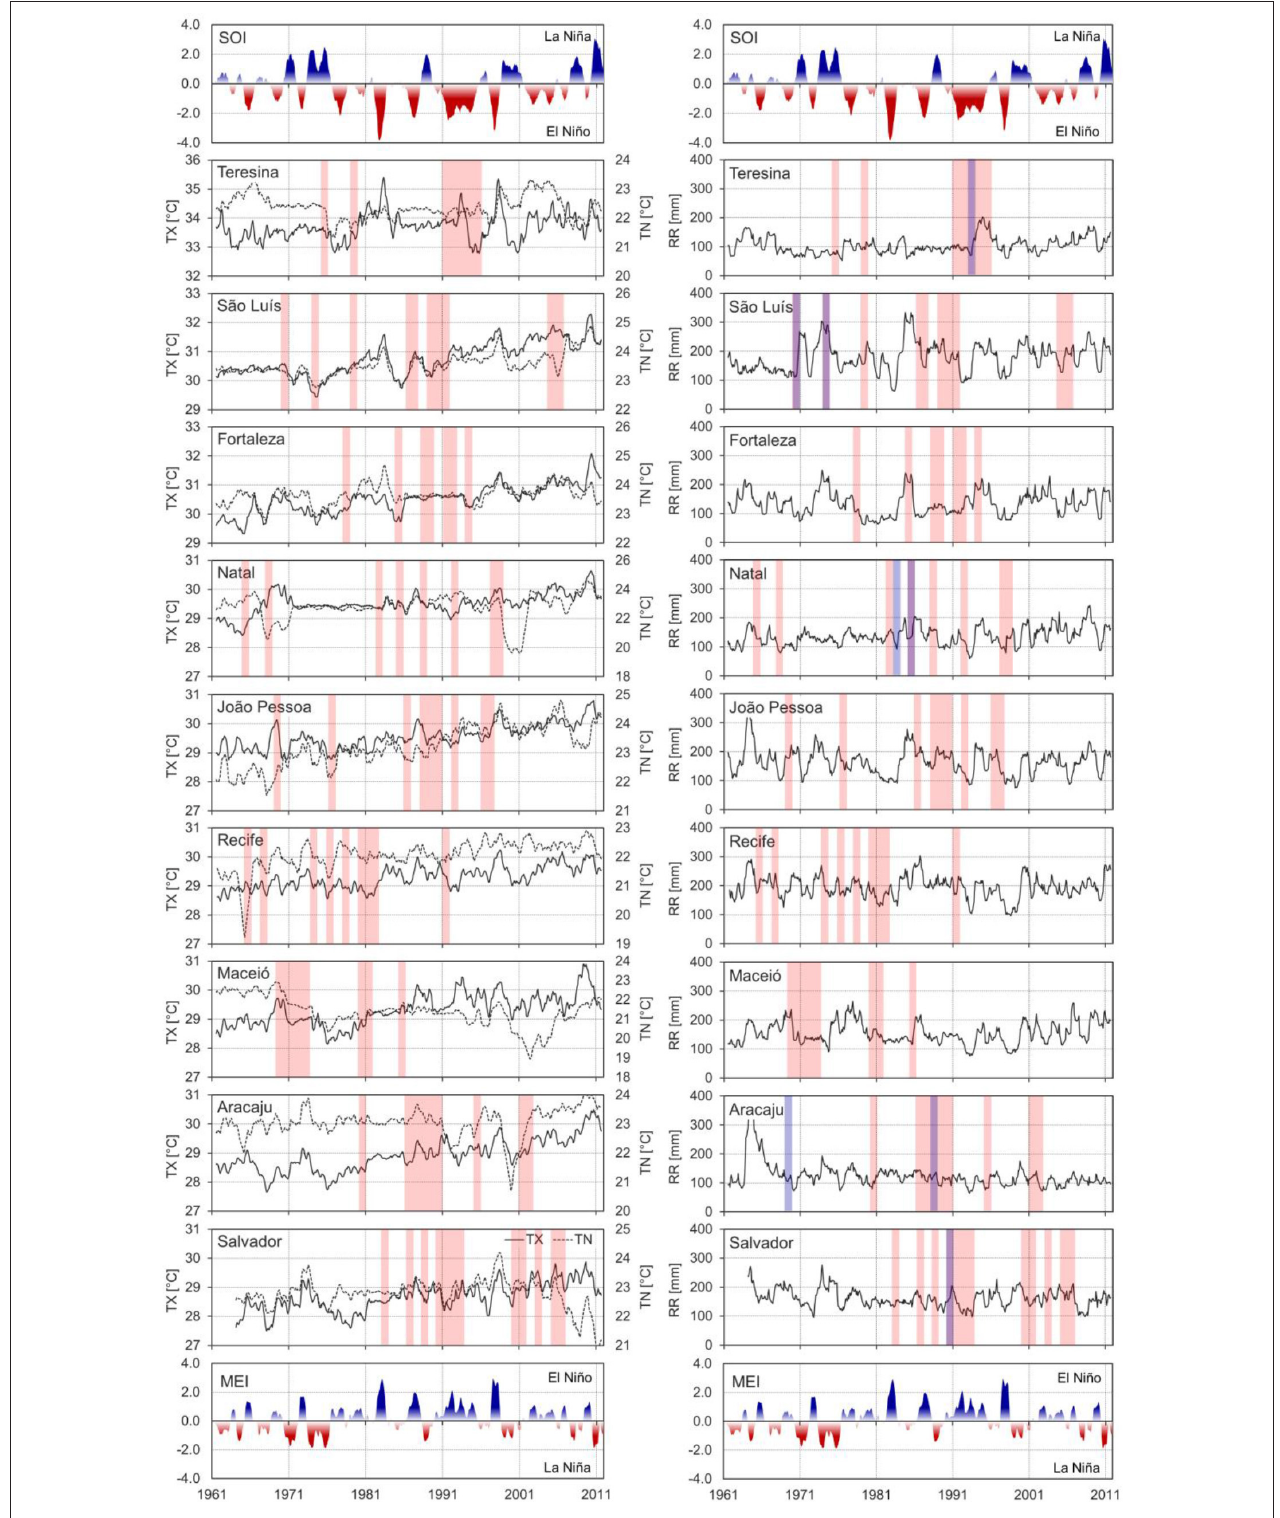
FIGURE 3 | Time series (12-month moving average) of temperature (TN: minimum and TX: maximum; left) and precipitation (right) at nine stations in NEB within 1961–2011 in comparison to two indices representing the El-Nino-Southern Oscillation. Break years as identified by the homogeneity tests are indicated by vertical bars [red for the tested temperature indices (left) and blue for precipitation (right; those of temperature are additionally given in red)].